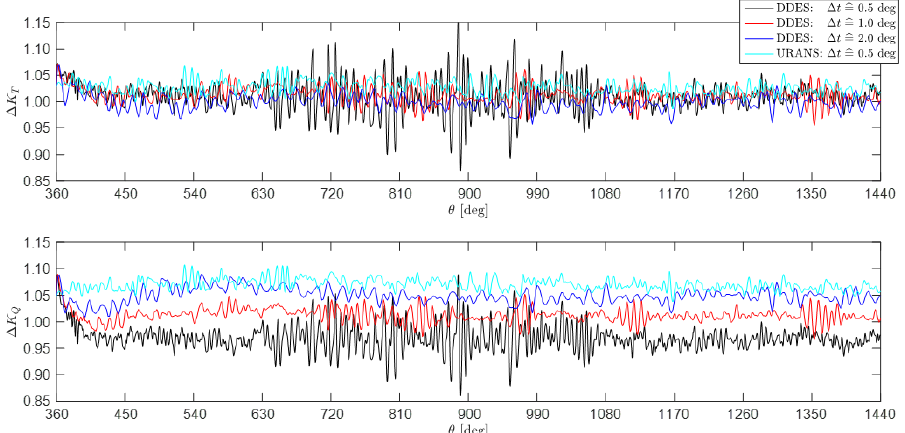
Figure 20. Time histories of the propeller thrust coefficient for PPTC Case 2. Full-scale DDES and URANS simulations with different time-steps.